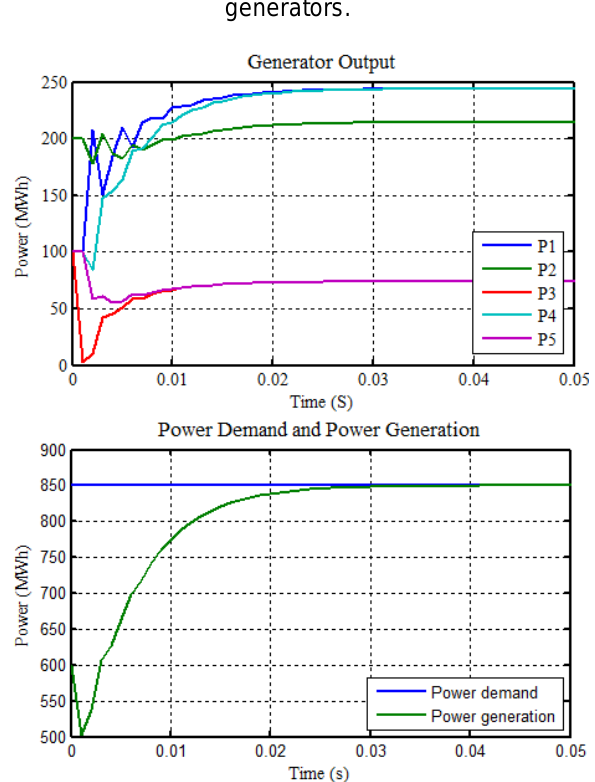
Figure 3. Case 1: the incremental cost of the five generators.